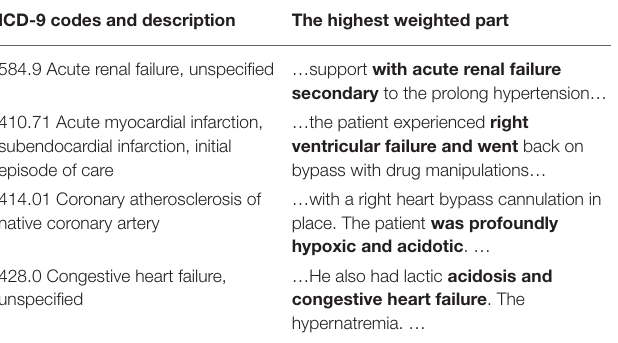
TABLE 7 | Presentation of clinical text fragments and their corresponding ICD codes (The bold part indicates the highest weight). ICD-9 codes and description